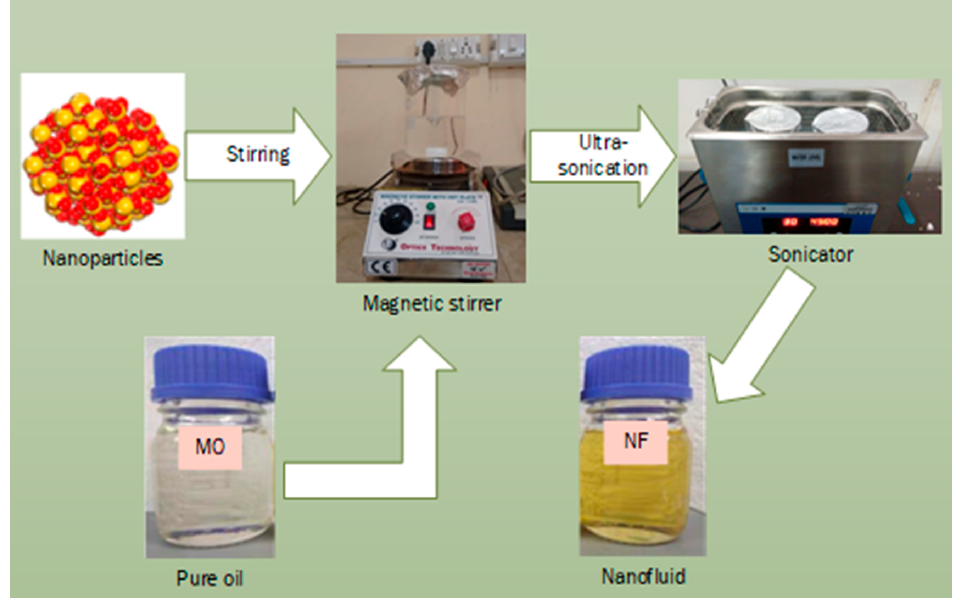
Figure 3. Process for the preparation of nanofluids.